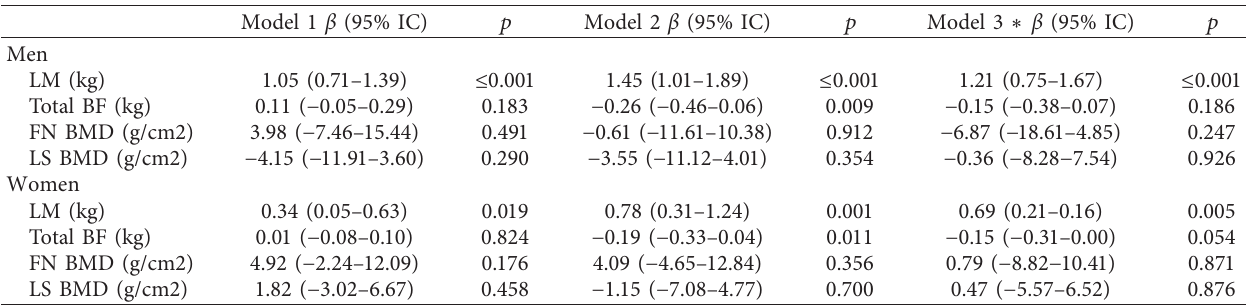
Table 3: Linear regression models for the prediction of body composition components on strength